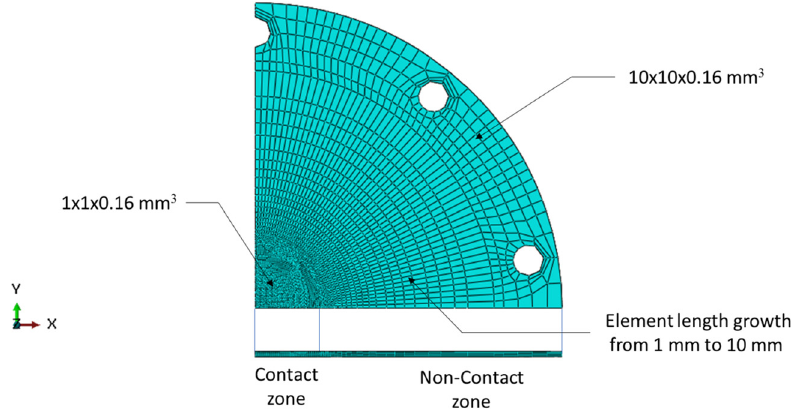
Figure 4: Meshing